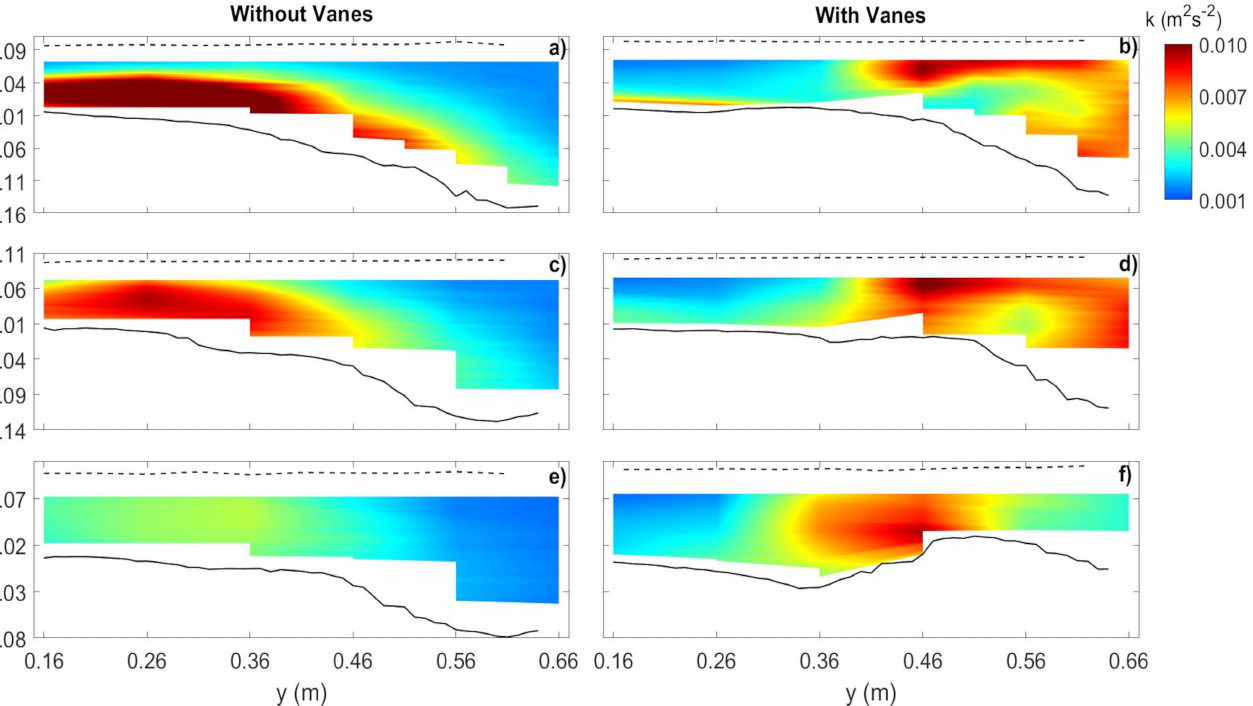
Figure 19. Turbulent kinetic energy k (m 2 · s − 2 ) as color scale, in the NV and the VF experiments, downstrem of the vane-field, at cross-sections: ( a ) x = 0.56 m. ( b ) x = 0.56 m. ( c ) x = 0.76 m. ( d ) x = 0.76 m. ( e ) x = 1.16 m. ( f ) x = 1.16